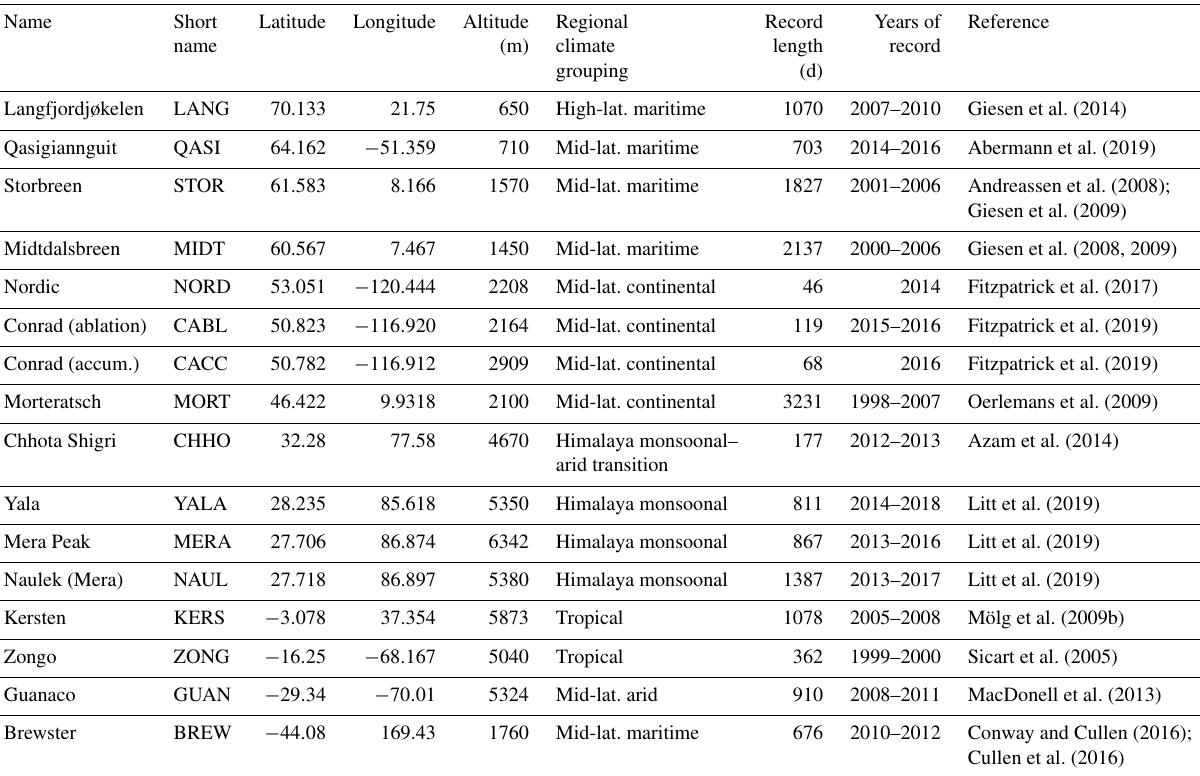
Table 1. Details of study sites listed by